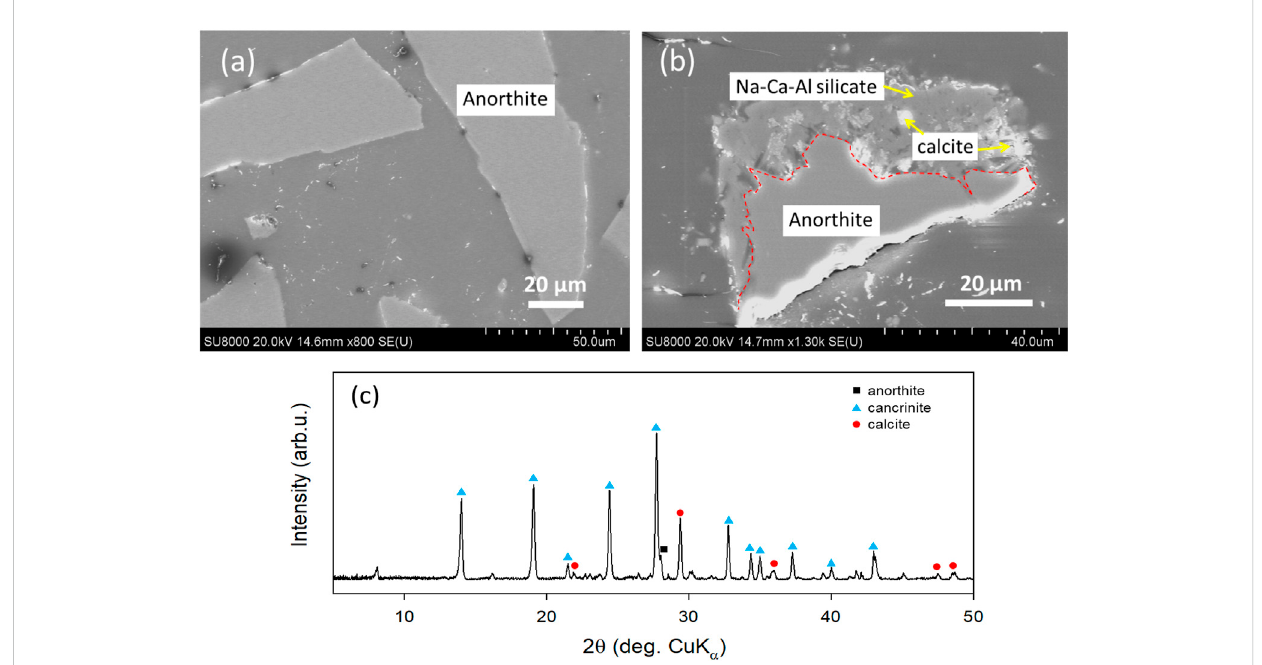
FIGURE 10 SEM images and XRD patterns of solid samples obtained after reaction of anorthite in (A) Milli-Q water and (B,C) 0.5 mol/L NaHCO 3 solution at 300 ° C for 5 days. A clear boundary between reacted and unreacted anorthite is marked with a red dashed line.